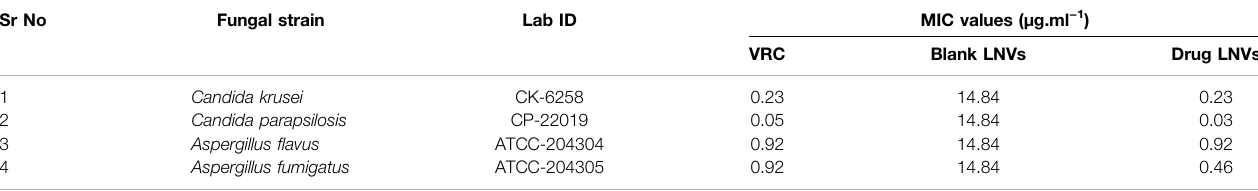
TABLE 3 | Values of minimum inhibitory concentration (MIC) of voriconazole (VRC) and its lipid nanovesicles (LNVs) against different fungal isolates ( n (cid:2) 3). Sr No